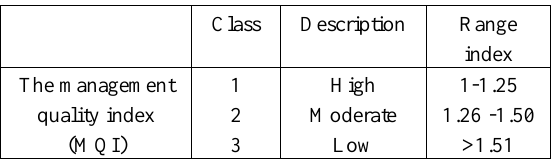
Table 7. Management quality index